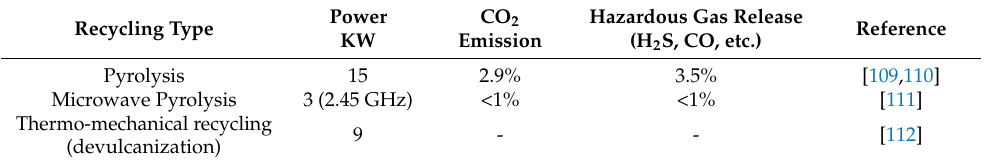
Table 4. The amount of energy and gas emissions generated by various techniques of rubber